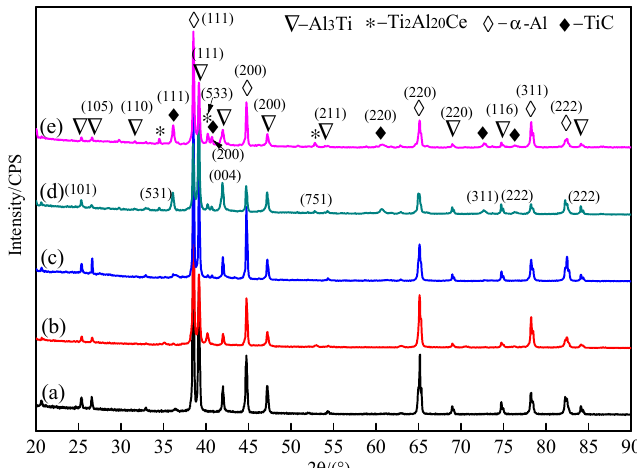
Figure 2. X-ray diffraction (XRD) patterns of pressing blocks complete reaction of: ( a ) 1#; ( b ) 2#; ( c ) 3#; ( d ) 4#; ( e ) 5#.